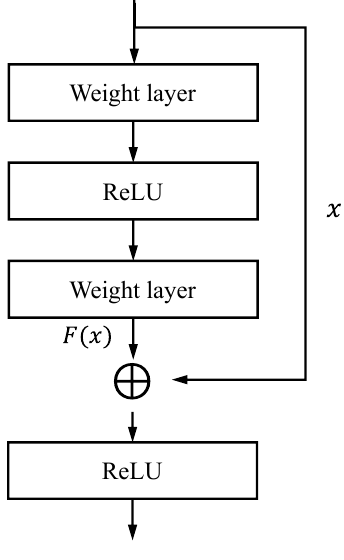
Figure 1. Residual neural